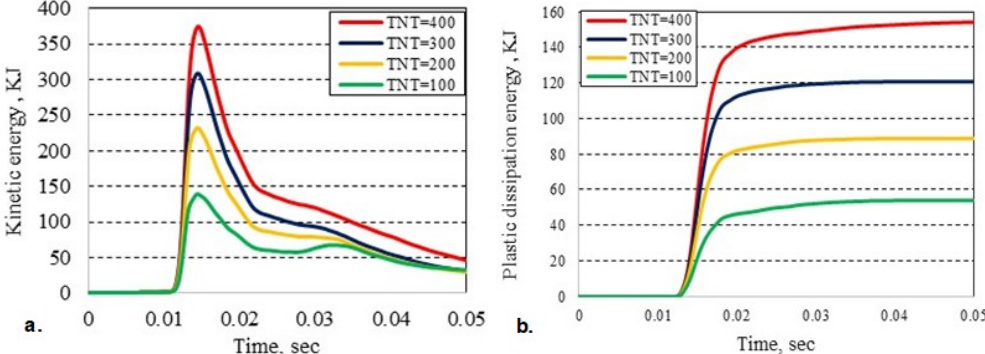
Figure 15: a. Kinetic energy with time. b. plastic dissipation energy with time.